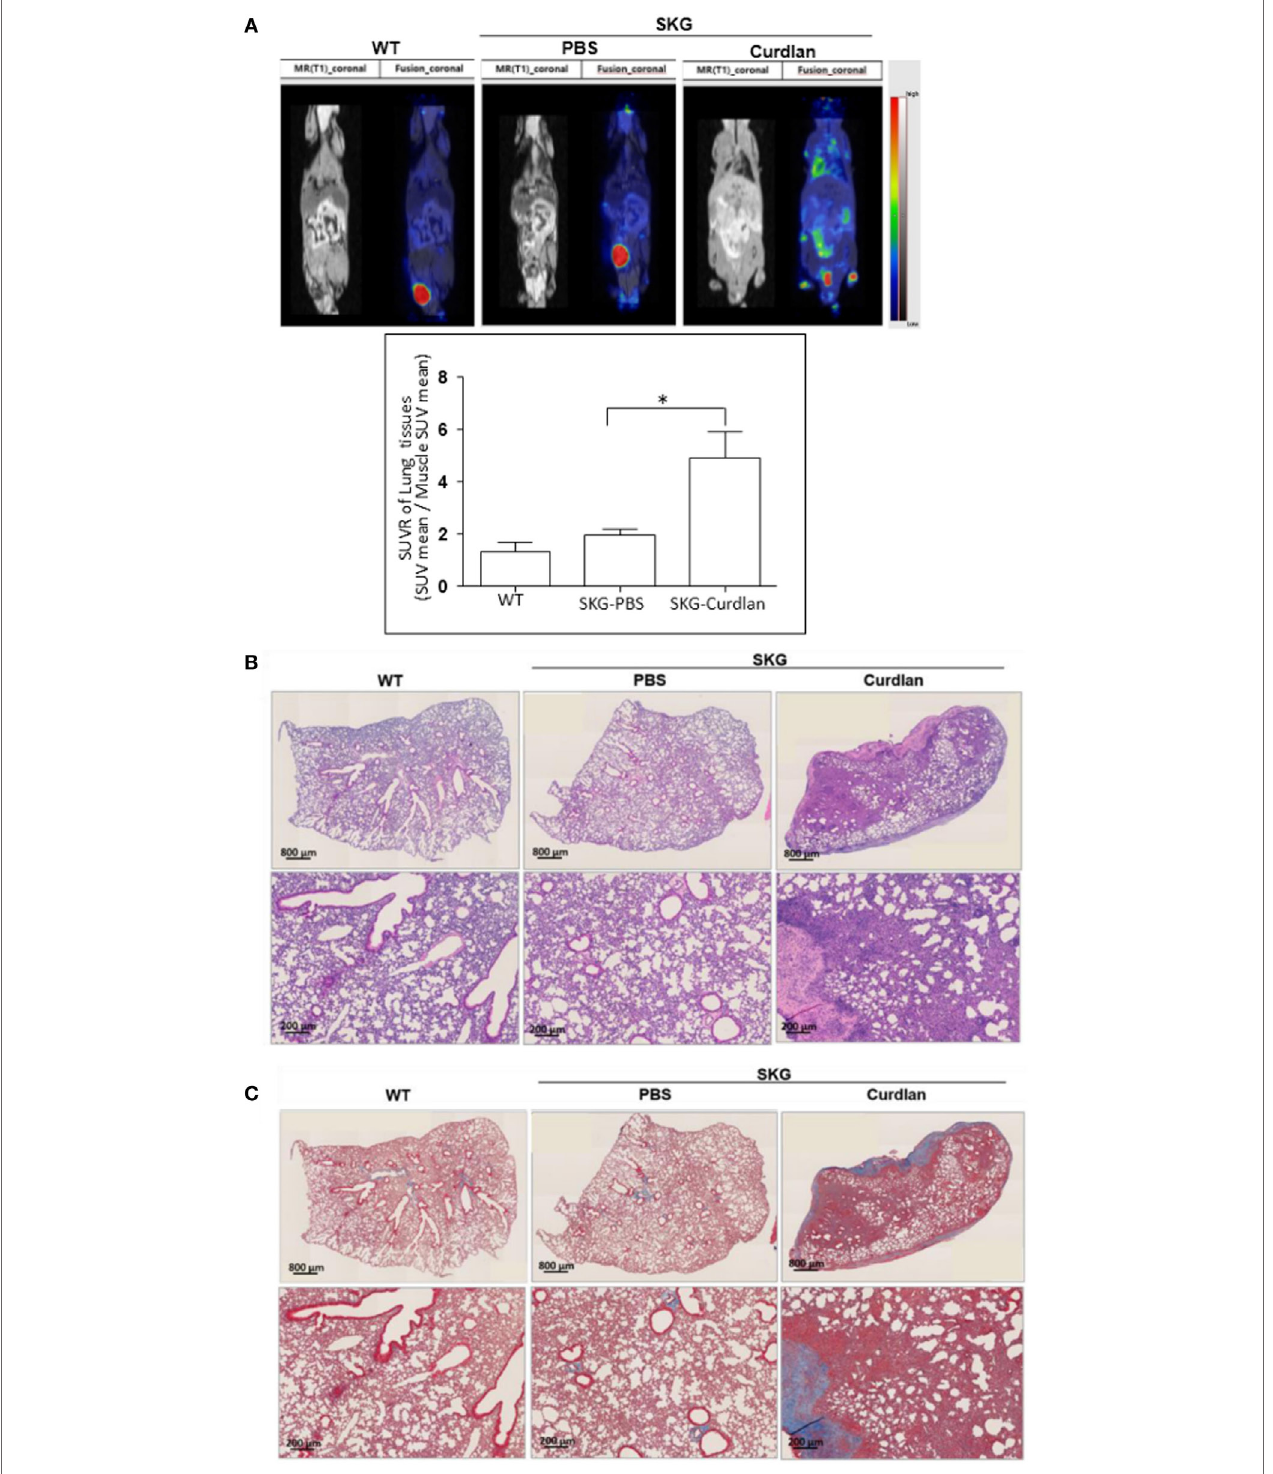
FigUre 1 | Interstitial lung disease (ILD) in curdlan-treated SKG mice. (a) PET-MRI performed at week 20 post-injection revealing inflammation in the peripheral joints, spine, intestine, and lung of the curdlan-treated SKG mice. (B) Hematoxylin and eosin staining of the lungs from BALB/c, PBS-treated SKG mice, and curdlan-treated SKG mice at week 22 post-injection showing inflammatory cell infiltration in curdlan-treated SKG mice. (c) Masson’s trichrome staining of lungs from BALB/c, PBS-treated SKG mice, and curdlan-treated SKG mice at week 22 post-injection showing fibrosis in the curdlan-treated SKG mice. Values in (a) are mean ± SEM. * p < 0.05 by Mann–Whitney U